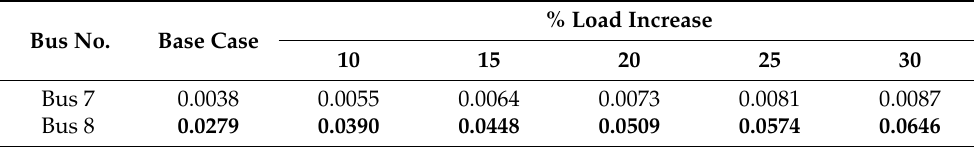
Table 12. Values of real power loss sensitivity